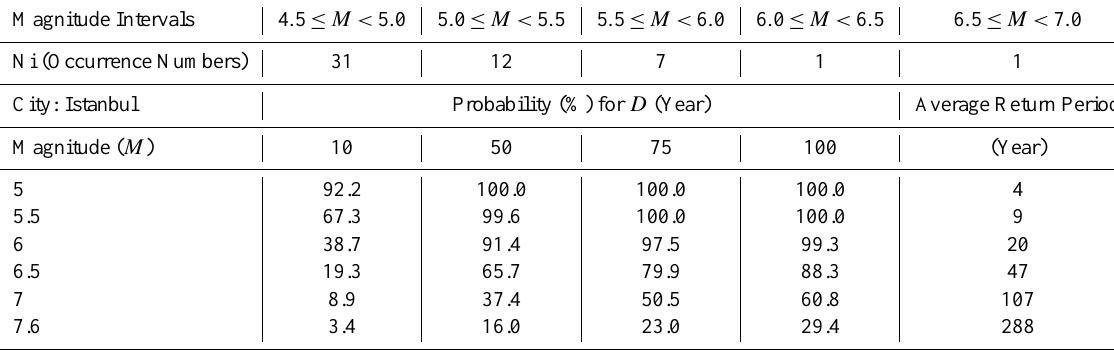
Table 3l. Earthquake occurrence probability (%) for D (Year) for Istanbul city. Magnitude Intervals